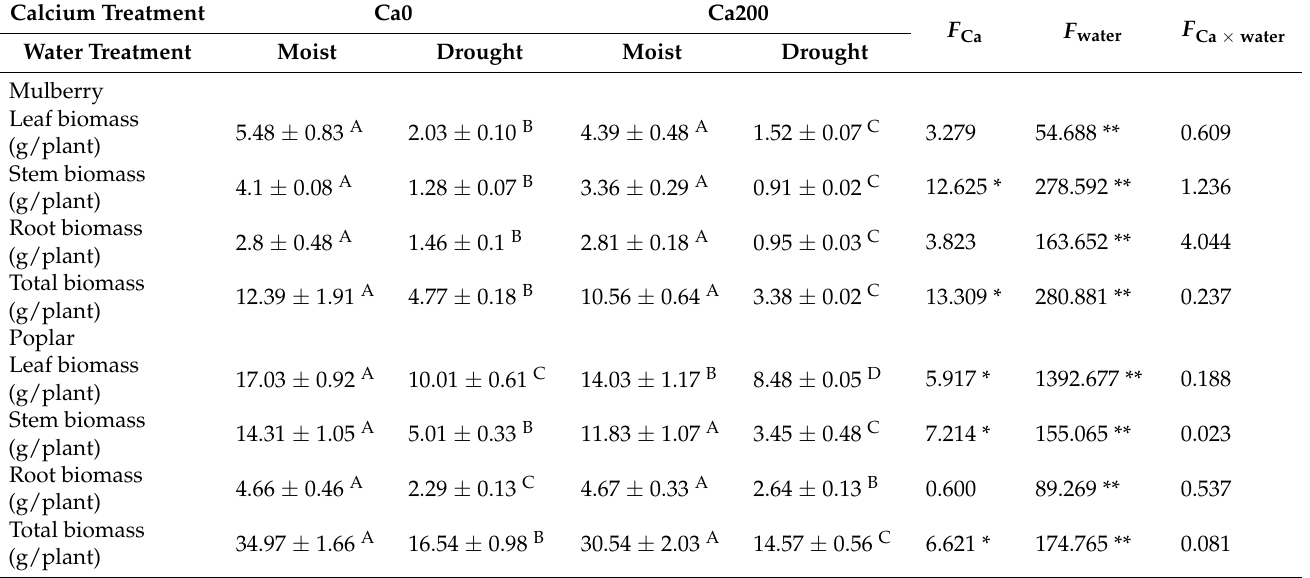
Table 4. Effects of water and Ca treatments on leaf biomass, stem biomass, root biomass, and total biomass of the two species. Different letters indicate significant differences ( p < 0.05) among treatments. Treatment values shown as mean ± SE (n = 6). Results of two − way ANOVA addressing effects of Ca and water treatments are summarized at the bottom. *, ** indicate that the F value is significant at p ≤ 0.05, and 0.01,